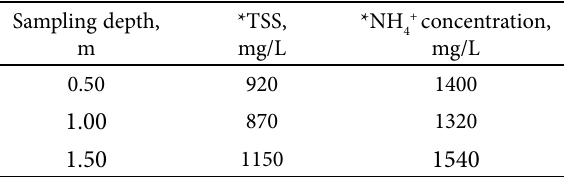
Fig. 4. Experimental results of ammonium ions removal efficiency (filtration run 50 min)